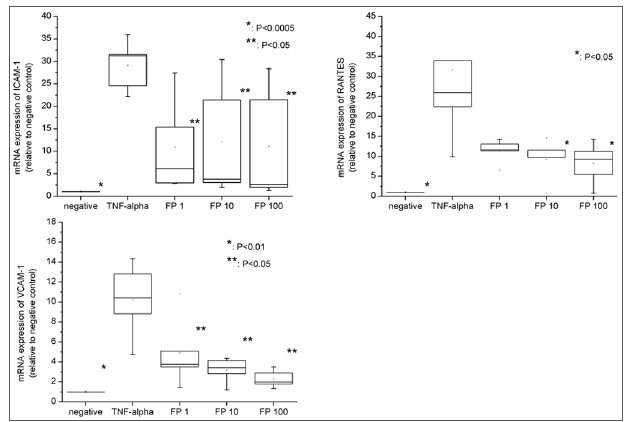
Figure 3. mRNA expression (by RTQ-PCR) of VCAM-1, ICAM-1 and RANTES. All the relative values were compared to negative control (considered to be = 1.0).